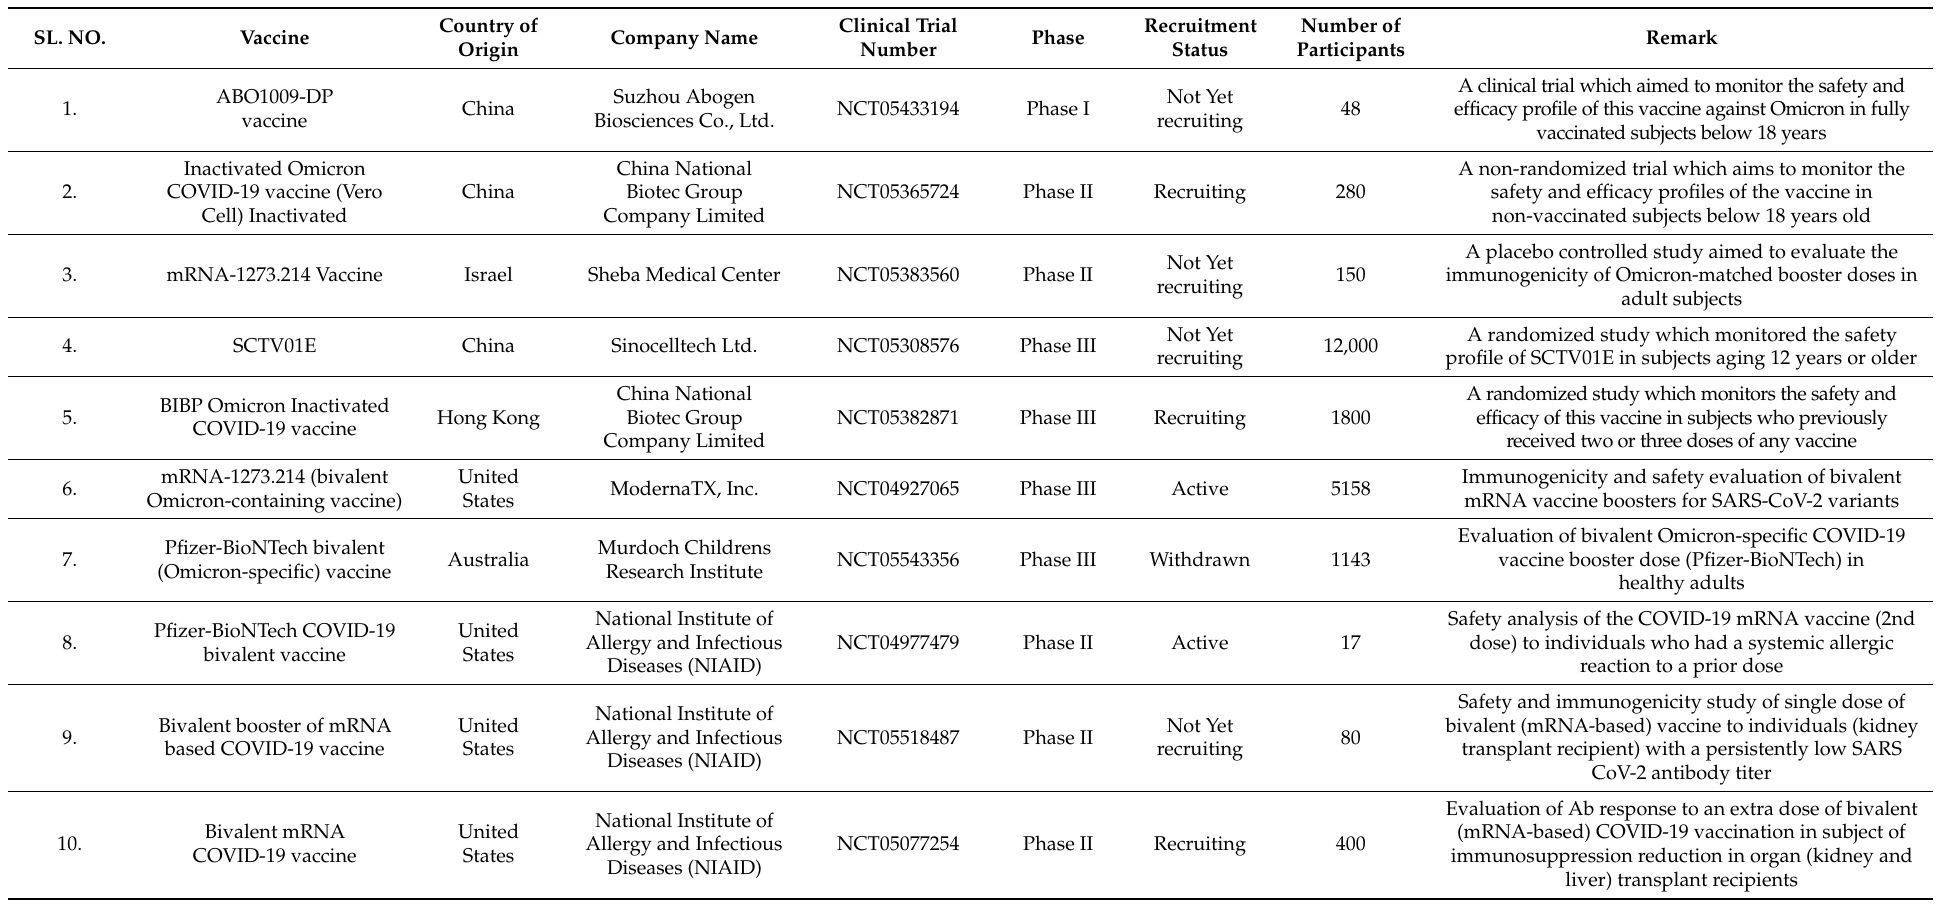
Table 2. Vaccines against Omicron in the clinical